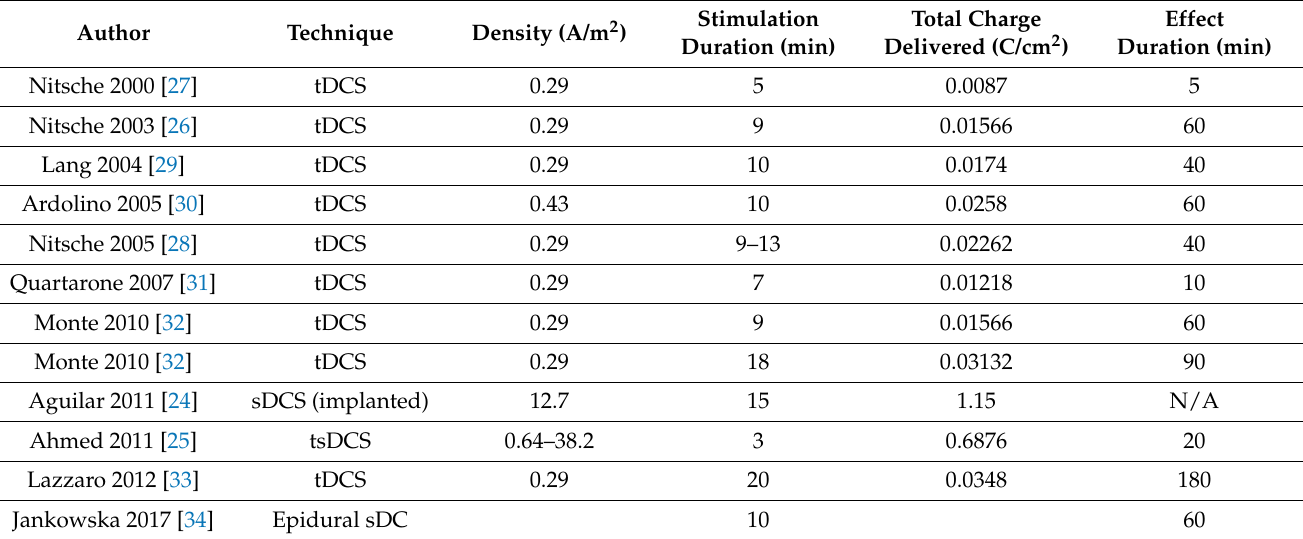
Table 1. Long-lasting stimulation effects from previous literature